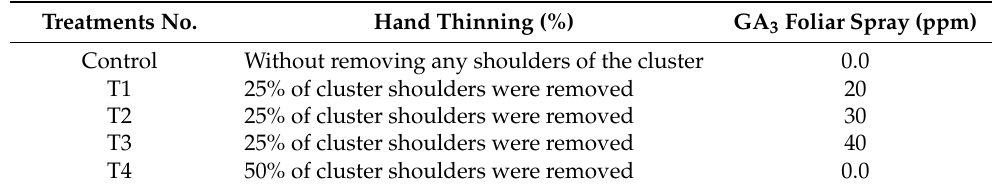
Table 1. Hand thinning percentage and GA 3 treatments of Sultanina (H4 strain) grapevines. Treatments No. Hand Thinning (%) Control Without removing any shoulders of the cluster